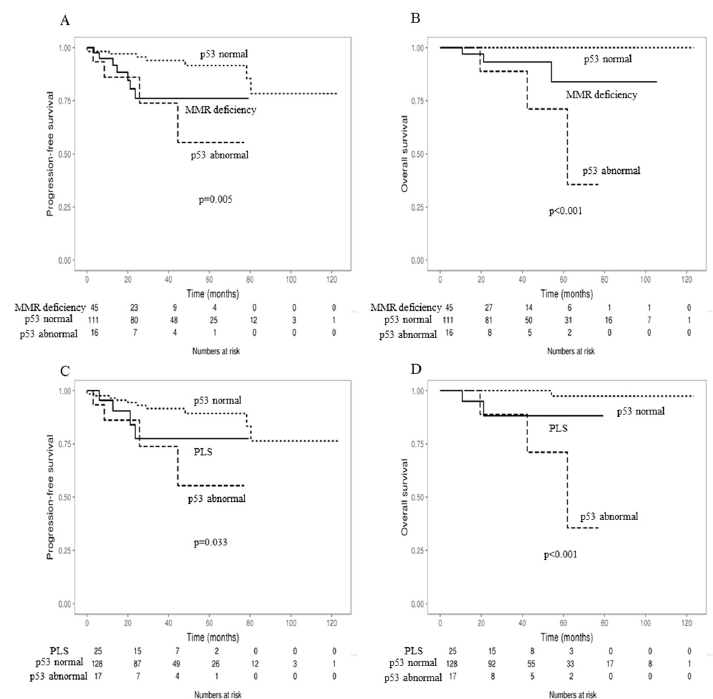
to the DNA mismatch repair (MMR) immunohistochemistry (IHC) status and MLH1 promotor